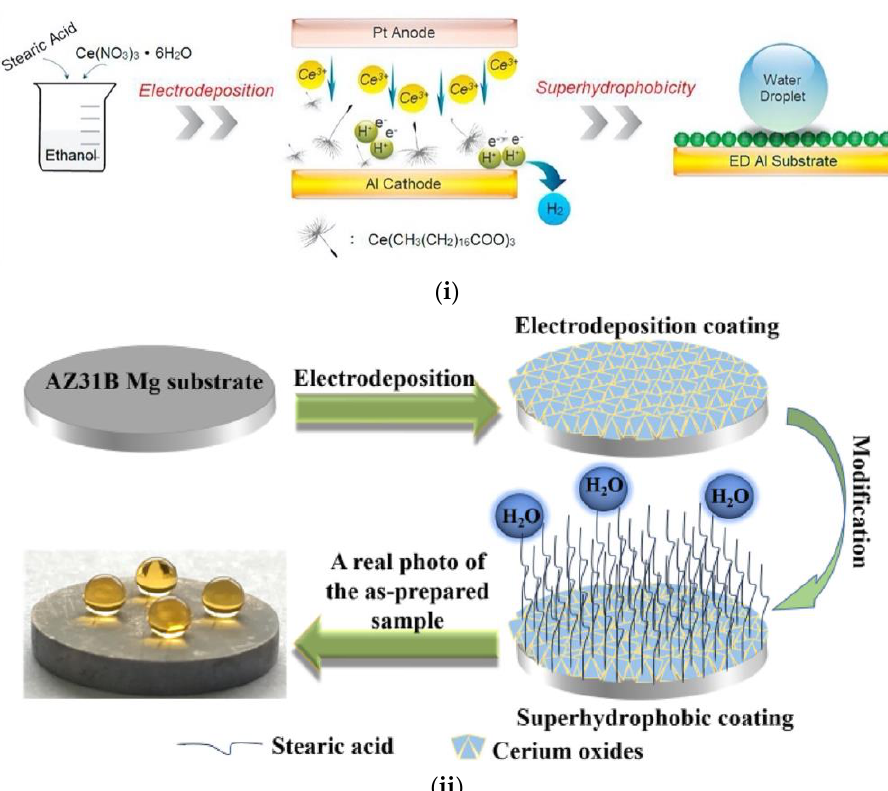
Figure 9. ( i ) Schematic representation of the fabrication method, as described by Binbin Zhang et al. [73]. Reproduced with permission from [73]. ( ii ) Schematic diagram of preparation process of the superhydrophobic coating formed on the AZ31B Mg substrate. Reproduced with permission from